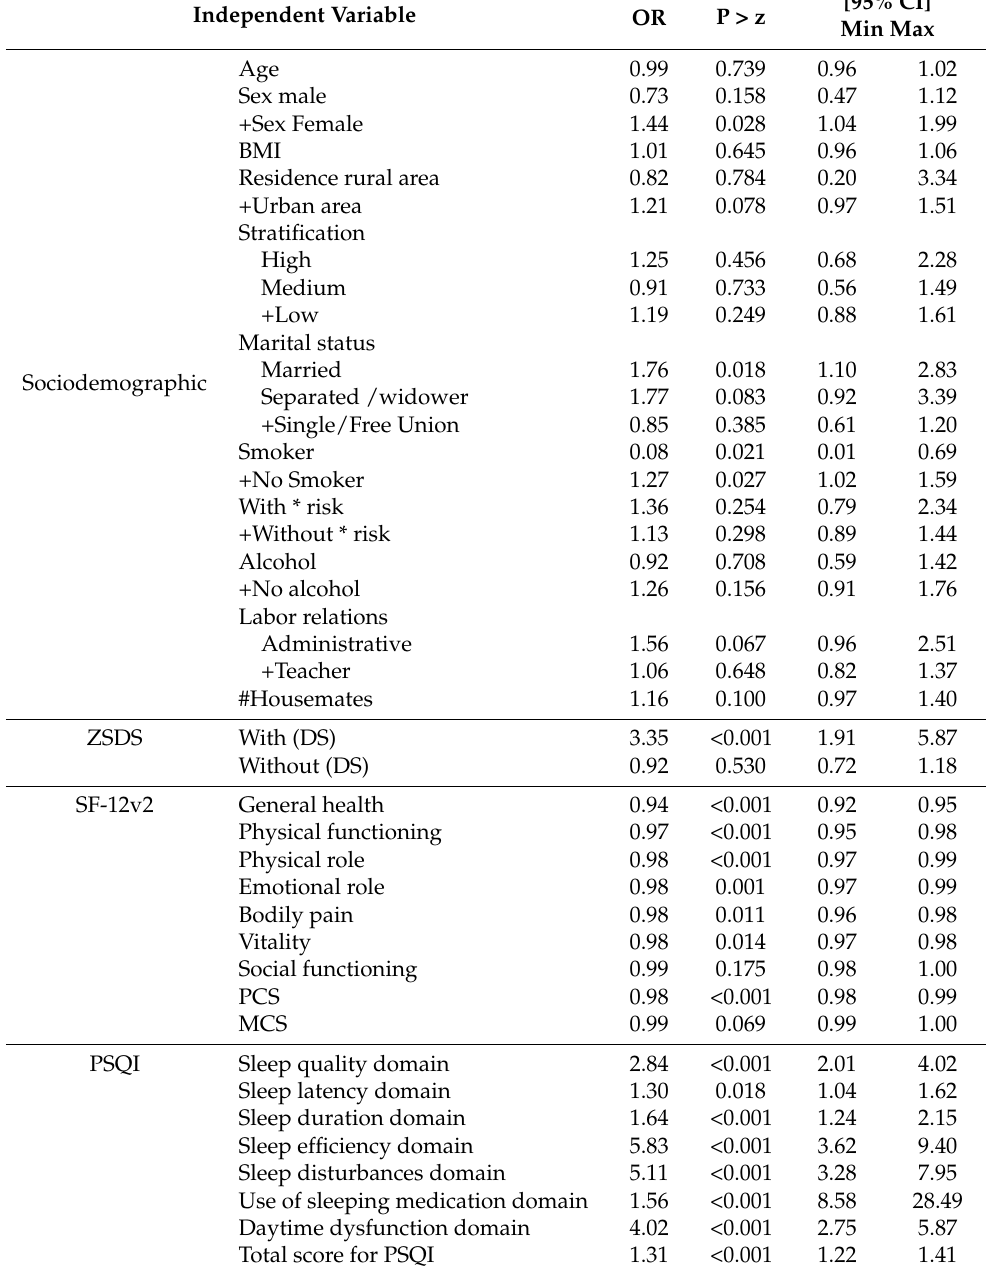
Table 3. Simple logistic regression model. Bivariate independent variables associated with the level of physical